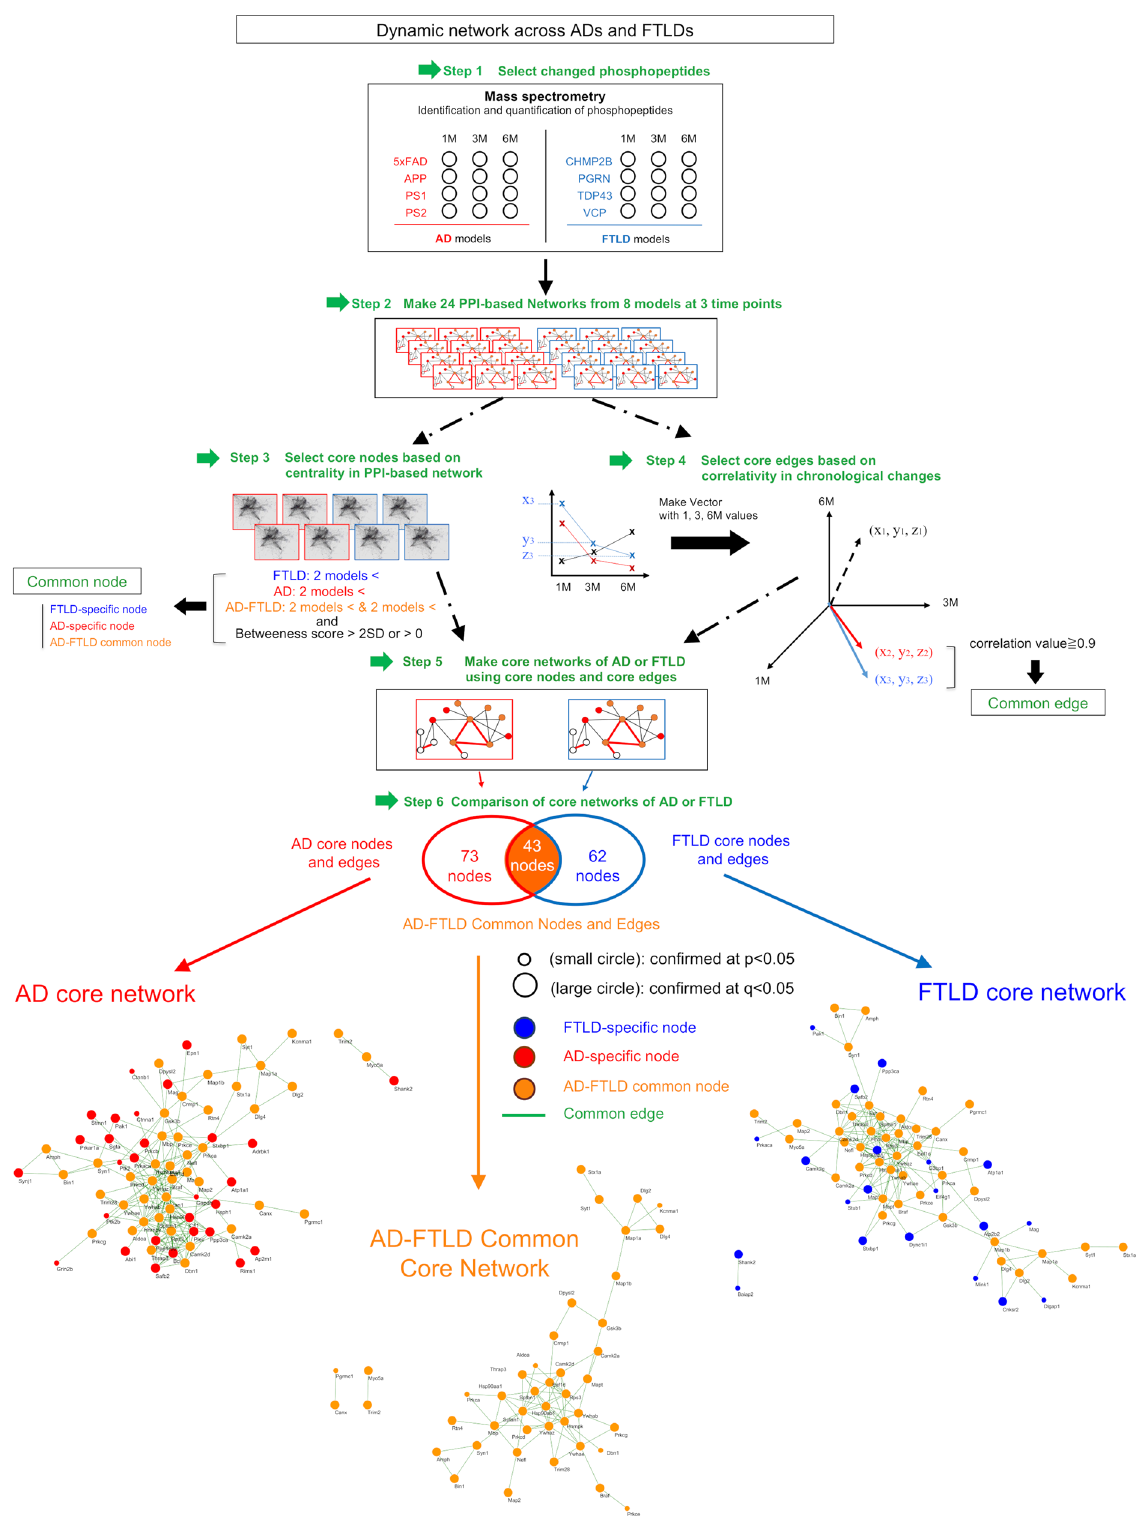
(Fig. 1, Step 6). Surprisingly, FTLD core network and AD core network were highly homologous and shared 46.7% of core nodes (Fig. 1). In addition, almost all the core nodes were selected not only by p values (small circle) but also by q values (large circles) (Fig.